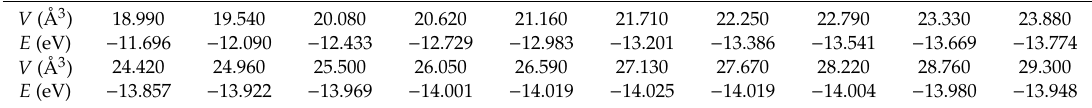
− E V data of B2-phase NiTi SMA under the ground state. Table 1. The calculated Table 1. The calculated E − V data of B2-phase NiTi SMA under the ground state.